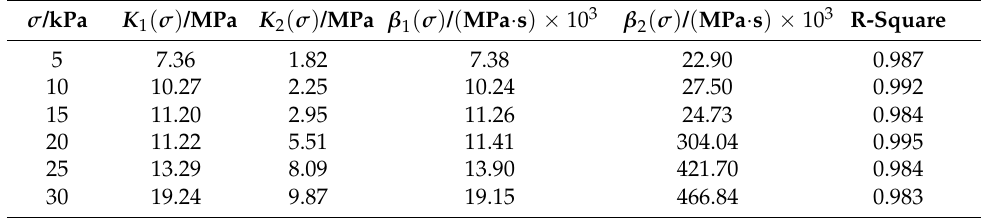
Figure 4. Shear creep curves and fitted 3D surface at σ = 10 kPa. ( a ) Shear creep curves under τ ; ( b ) Fitted curved 3D surface. Table 2. Fitted direct shear creep